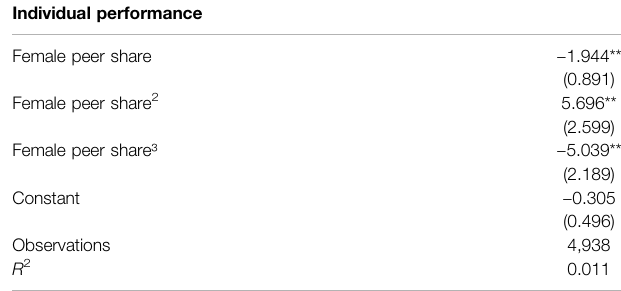
TABLE 5 | Regression results for within-ranks effects for men for a random group of job functions (Commercial, General Engineering and Geosciences). Individual